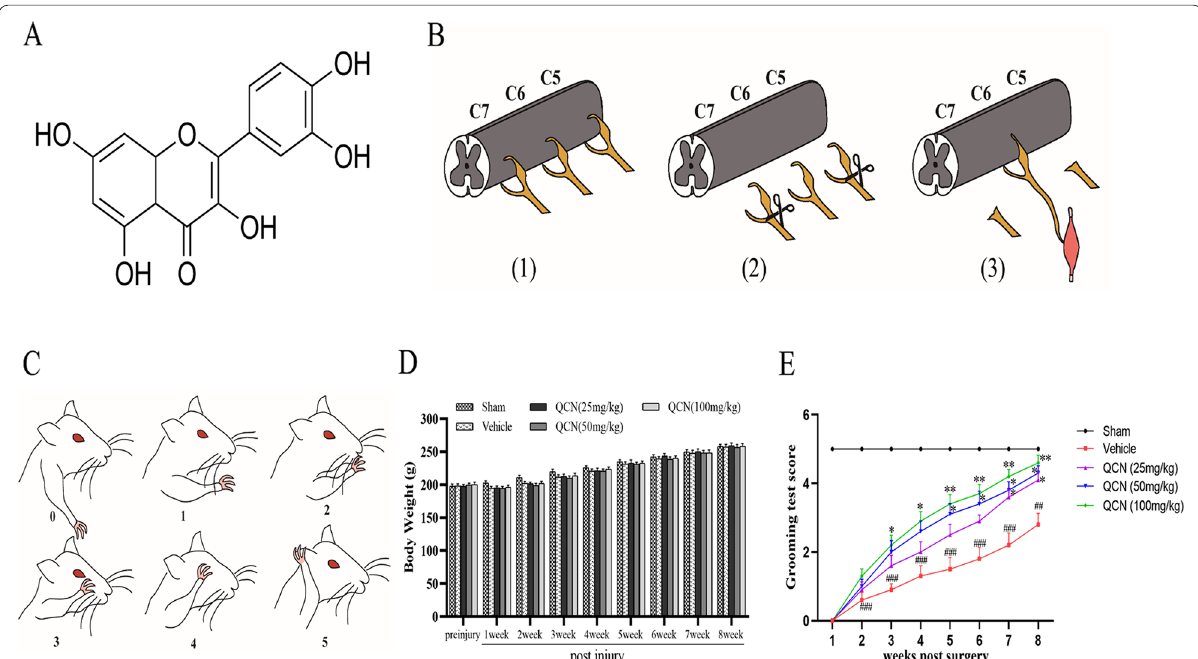
Fig. 1 Effects of QCN on the motor function recovery at week 8 post‑avulsion. A Chemical structure of quercetin (QCN). B Schematic diagram showing spinal root avulsion‑reimplantation surgical procedures. (1) Normal anatomic construction of C5‑C7 spinal cord segments; (2) Avulsion of right C5‑7 ventral and dorsal roots; (3) Reimplantation of C6 to the ventral surface of the corresponding spinal segment. C Schematic scoring systems of the Terzis grooming test (TGT). D The average body weights of rats in different experimental groups. E The average TGT scores of rats in different experimental groups. Data are expressed as the mean SEM ( n 10). ## p < 0.01 and ### p < 0.001 vs the sham group; * p < 0.05 and ± = ** p < 0.01 vs the vehicle